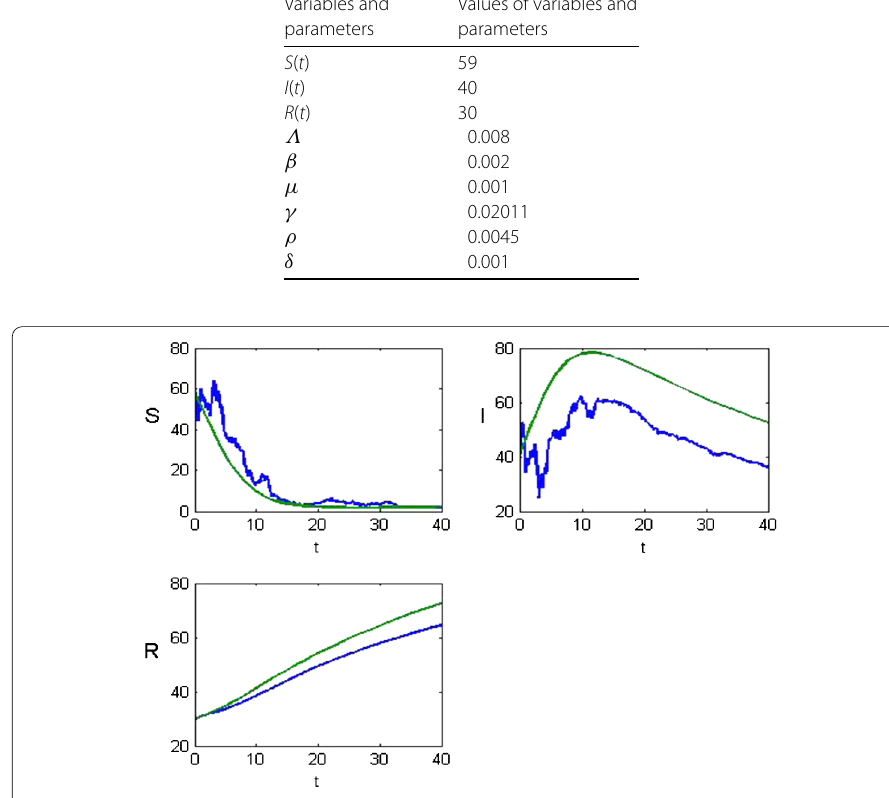
Figure 1 Graphs of (S) susceptible community using a deterministic method (green line) and from a stochastic solution (blue line), (I) infected people by coronavirus using a deterministic method (green line) and from a stochastic solution (blue line) and (R) recovered using a deterministic method (green line) and from a stochastic solution (blue line). The stability of stochastic graphs shows a better expression